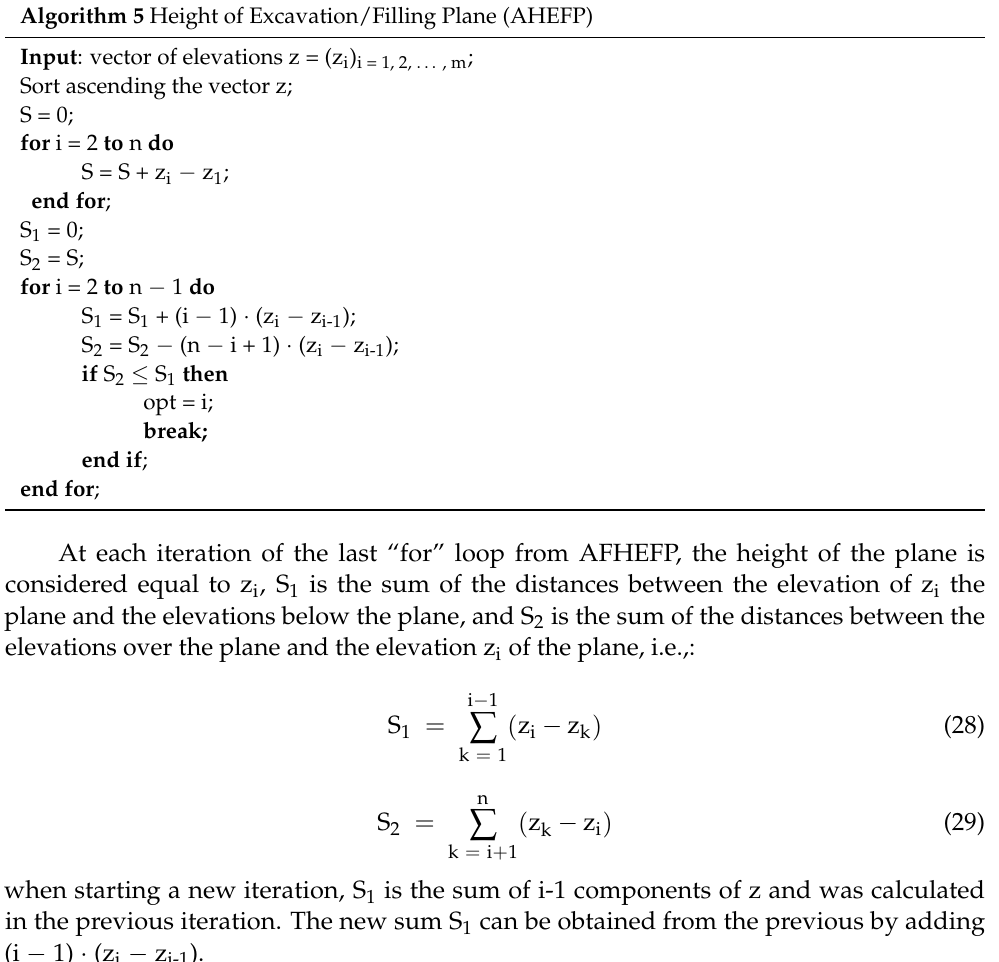
Algorithm 6 divide and conquer for optimum excavation/filling plane